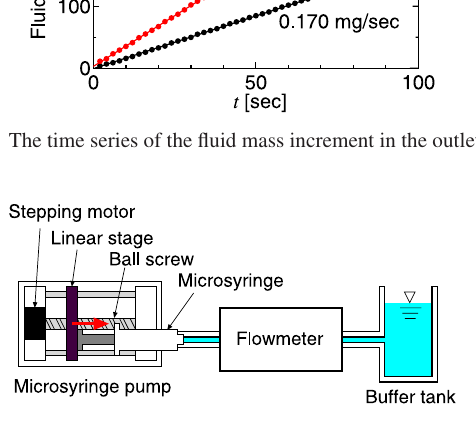
Fig. 4 Schematic diagram of the microsyringe